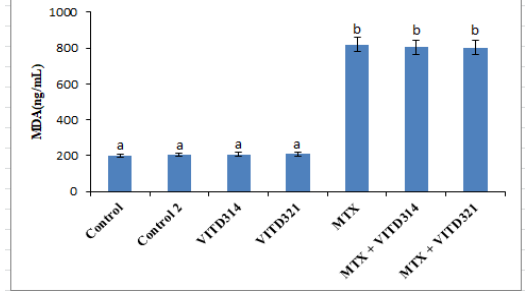
Figure 1. Effects of various treatments on malondialdehyde (MDA)contents in the jejunum tissue homogenate of rats. Each value represents mean ± standard error of means (SEM).